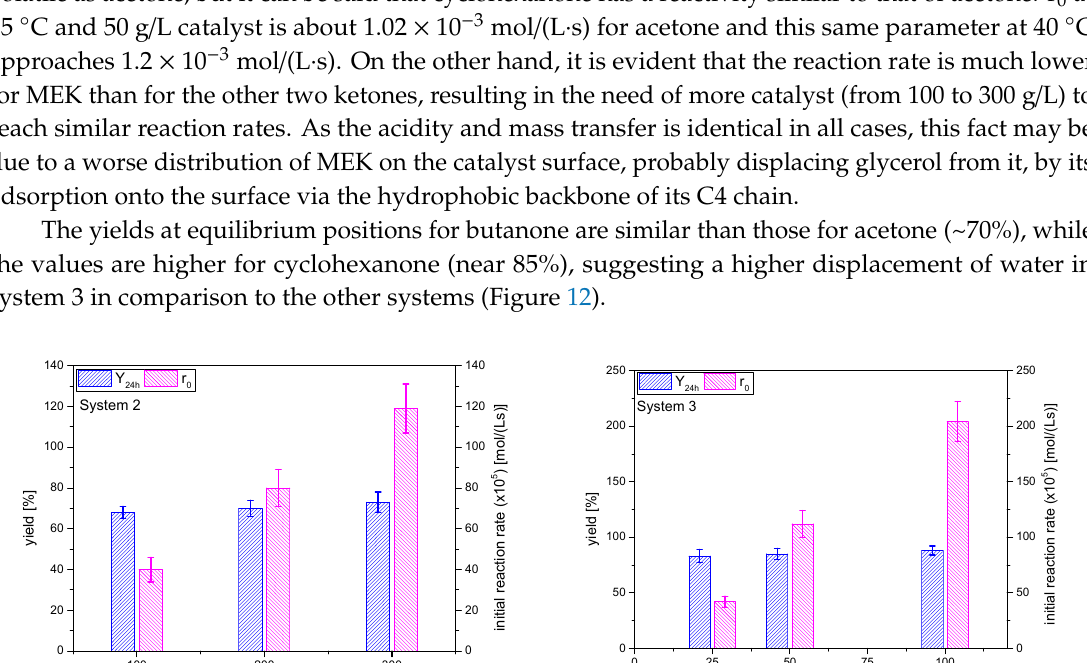
Figure 11. Influence of the molar excess of acetone on the yield of solketal 1 at 24 h and the initial reaction rate (Reaction conditions: acetone/glycerol molar ratio, 6:1; temperature, 25 °C).